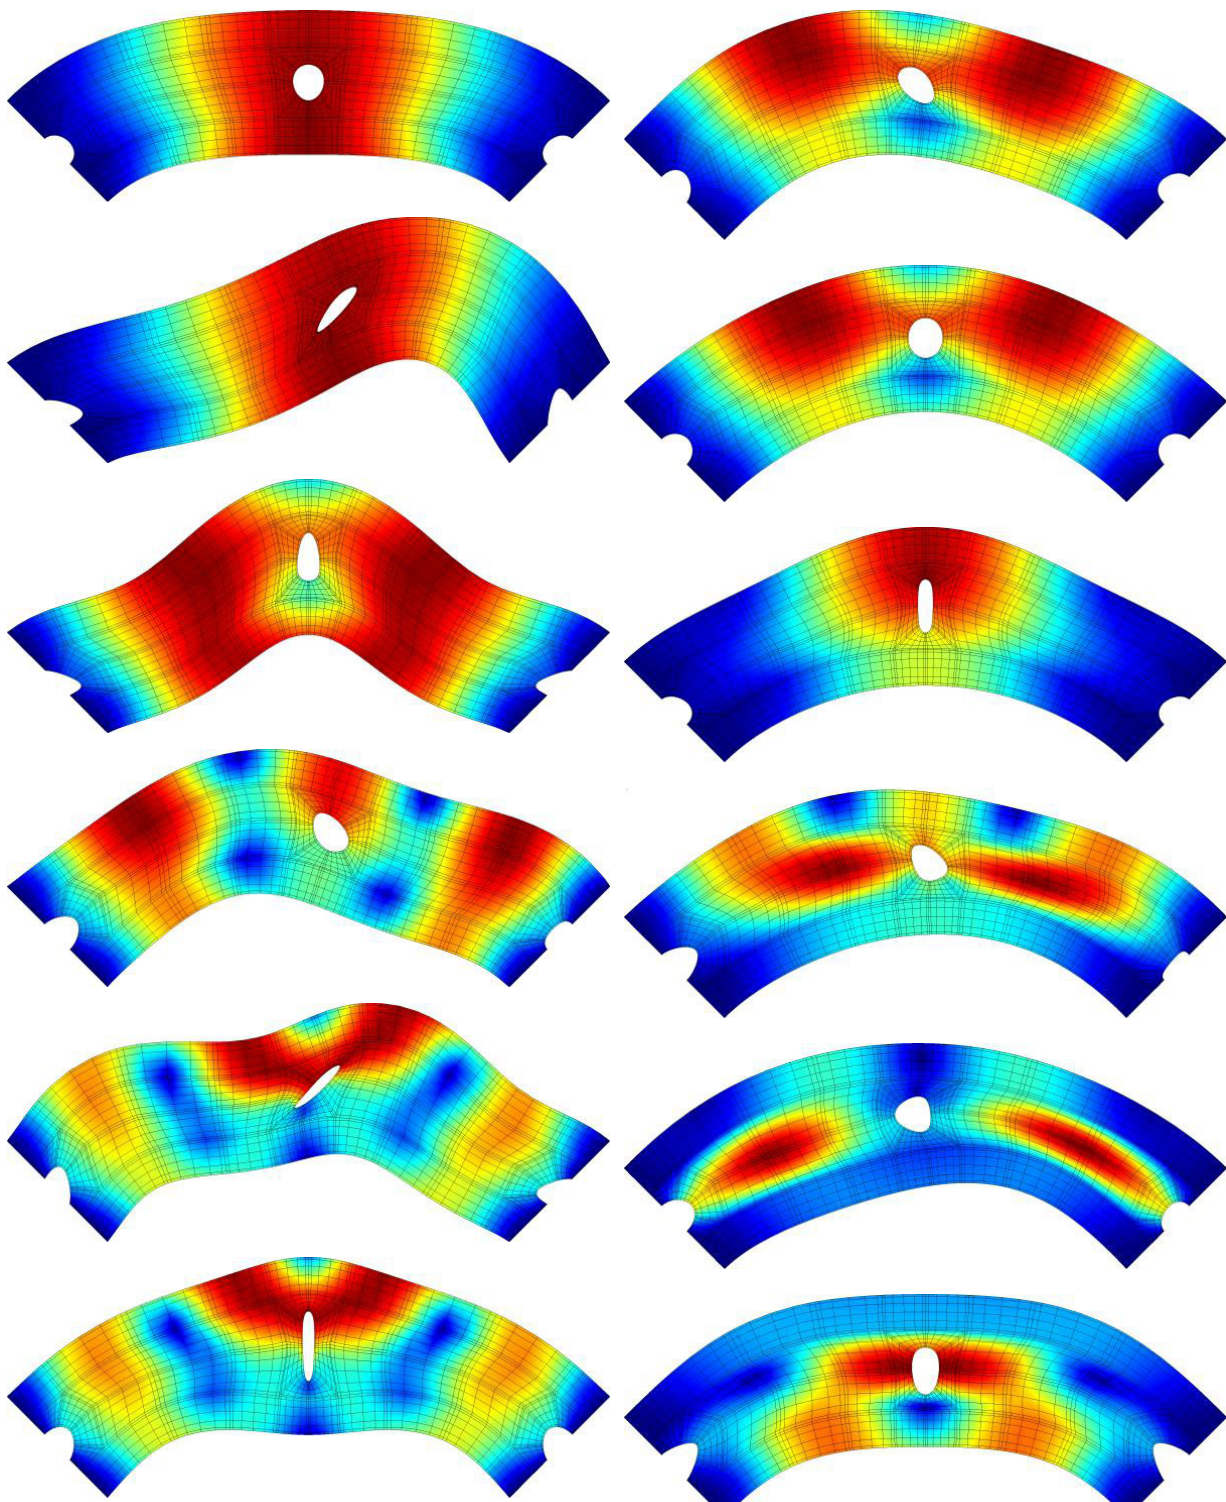
Figure 21: First six mode shapes of a composite arch with ratio E s / E c = 10 using N = M = 7 grid per element. Figure 22: First six mode shapes of a composite arch with ratio E s / E c = 100 using N = M = 7 grid per